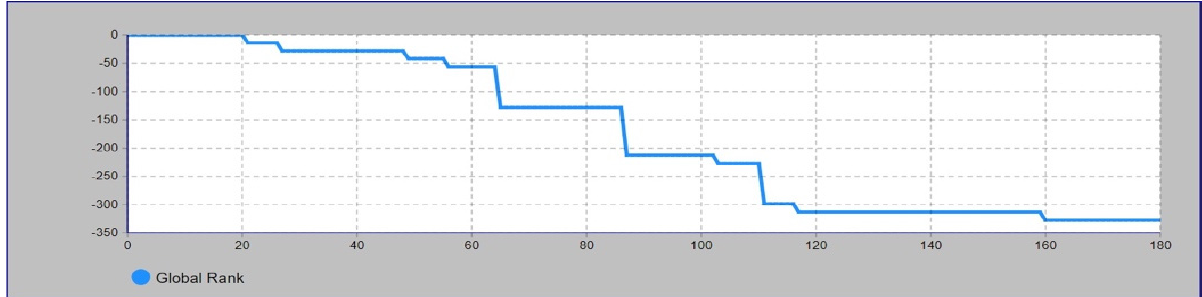
Figure 9. The time chart depicts the history of the contribution of the global rank during 180